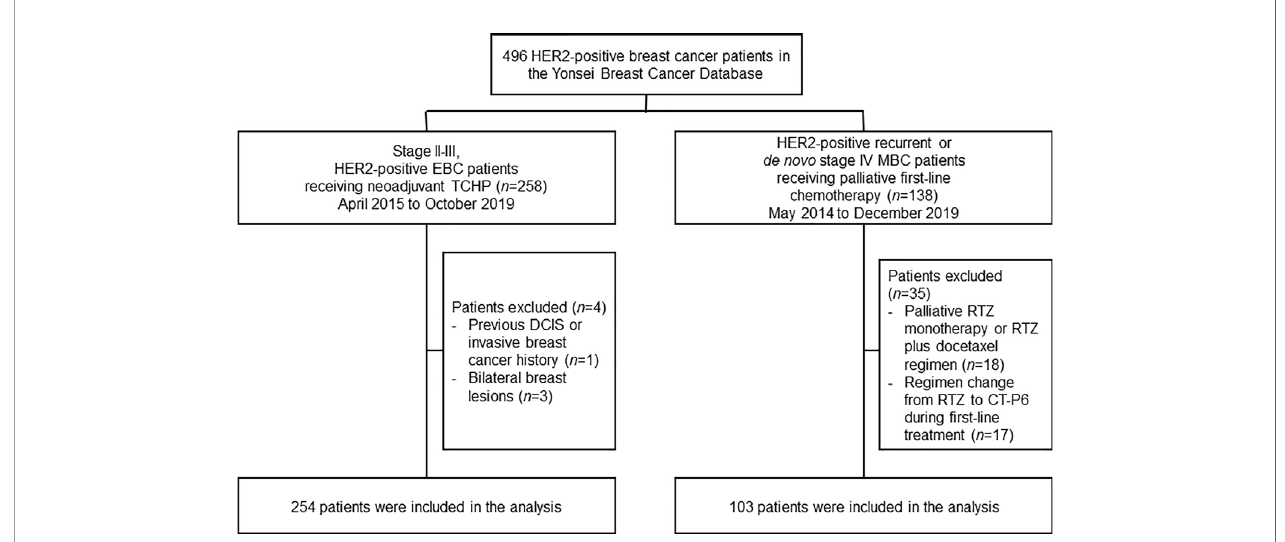
FIGURE 1 | Study pro fi le. DCIS, ductal carcinoma in situ; EBC, early-stage breast cancer; HER2, human epidermal growth factor receptor 2; MBC, metastatic breast cancer; RTZ, reference trastuzumab; TCHP, docetaxel – carboplatin – RTZ or CT-P6 –